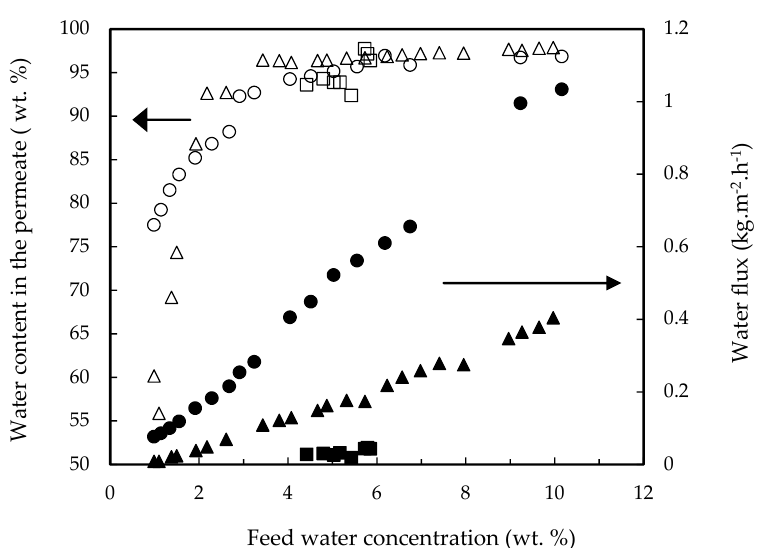
Figure 8. Water permeation fluxes (open symbols) and water concentration in permeate (closed sym- bols) as a function of feed water content for the PERVAP™ 1131 membrane at different